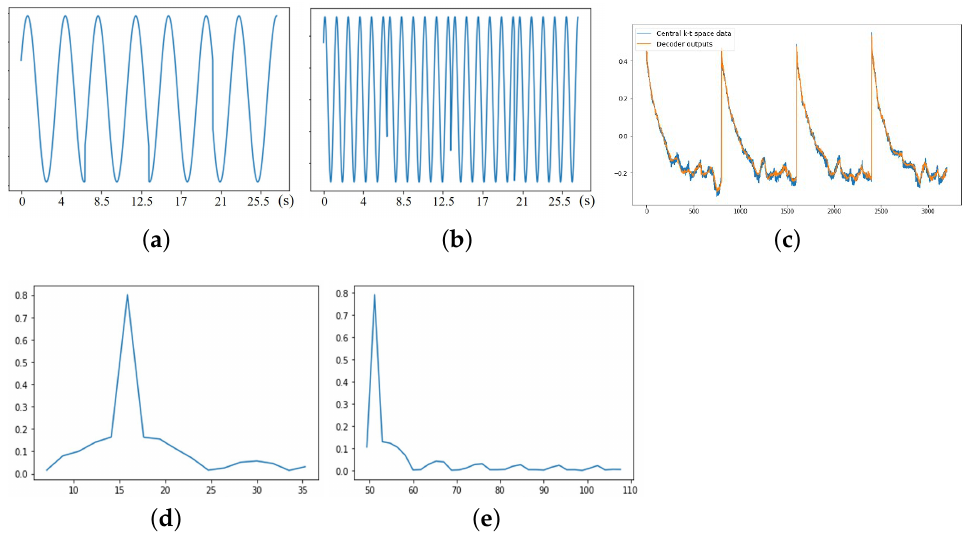
Figure 4. ( a ) Respiratory latent vector. ( b ) Cardiac latent vector. ( c ) VAE training comparison. ( d ) Respiratory rate (bpm). ( e ) Heart rate (bpm). Estimated latent vectors from subject #2, who has bradycardia. ( a , b ) are the respiratory and cardiac latent vectors obtained from the encoder. The x -axis is the time in seconds. ( c ) shows the comparison between the output of the decoder and the central k-t space data from one of the coils. ( d , e ) correspond to the Fourier transform of the respiratory and cardiac latent vectors. The bandlimited constraint, together with the sparsity penalty, enables us to recover the cardiac and respiratory signals reliably, even in the presence of strong signal modulations. From ( e ), we see that the estimated heart rate from the dense VAE is 53 bpm, which is roughly the same as the average heart rate of 55 bpm, which was obtained on the